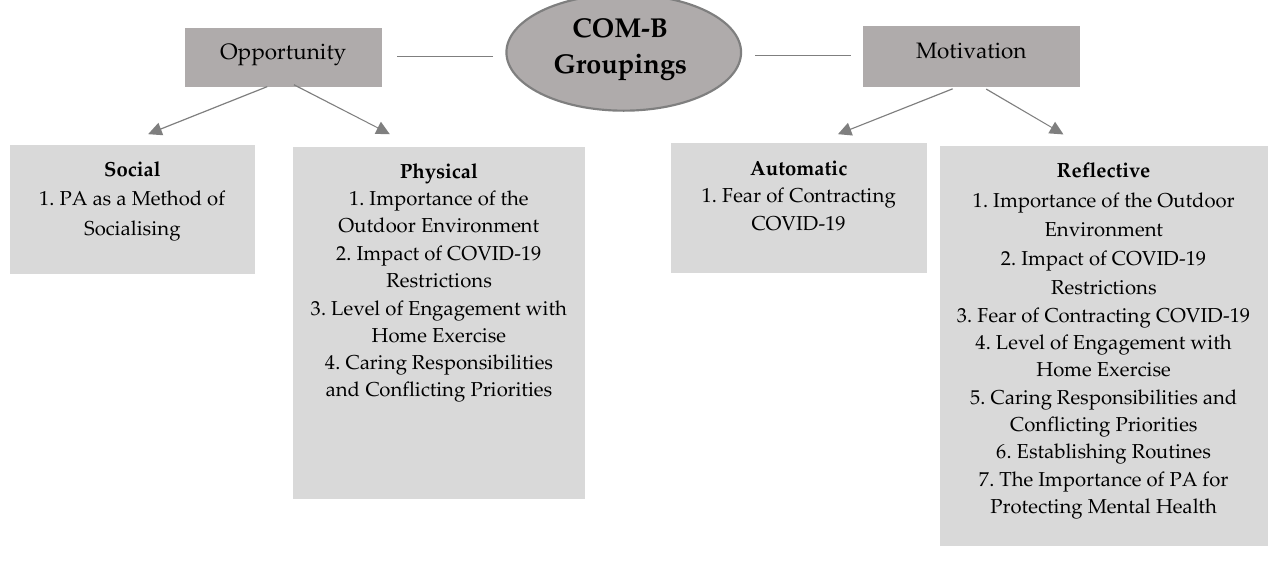
Figure 2. Themes mapped onto COM-B dimensions.